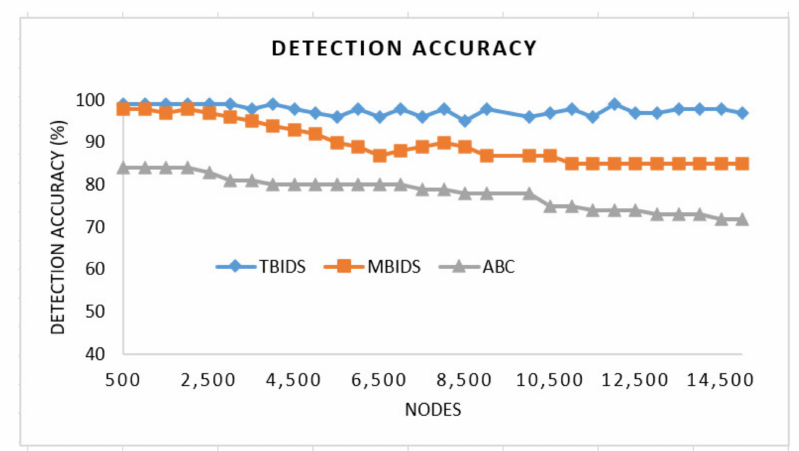
Figure 9. Detection accuracy for the large-scale network.